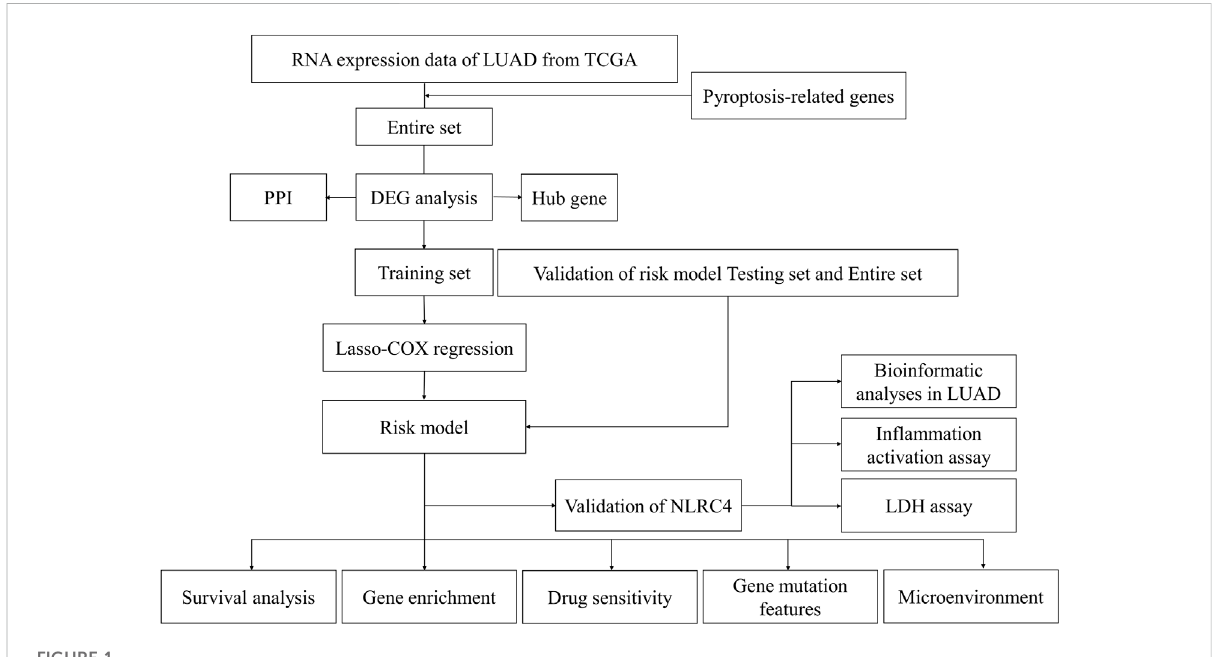
FIGURE 1 Schematic overview of the work fl ow in this